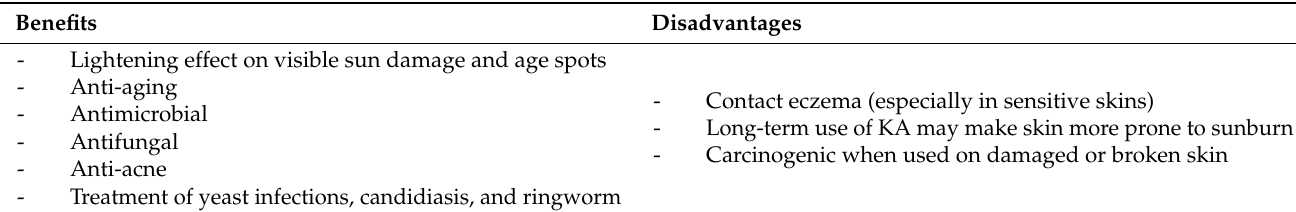
Table 2. Positive and negative effects of using KA for skin